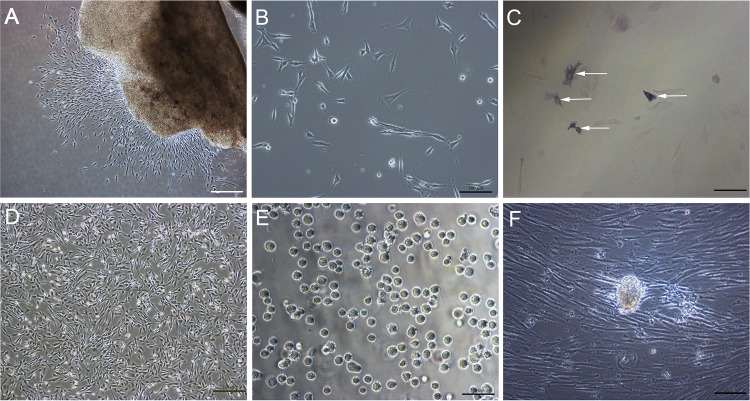
Culture of bovine embryonic fibroblasts.(A) Outgrowth of fibroblasts from a section of fetal bovine skin. (B) Bovine embryonic fibroblasts demonstrating a heterogeneous population of cells. (C) AP-positive cells within the population of bovine embryonic fibroblasts. (D) Several floating cells growing on top of fibroblasts. (E) Several cells displaying a rough surface with a long cilium. (F) Cell clusters that occur spontaneously in adherent cultures of naive skin fibroblasts. A-D, F: Scale bar = 100 μm; E: Scale bar = 50 μm.